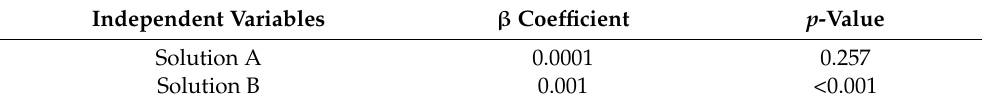
Figure 2. ( a ) Effect of TPP concentration on particle size; ( b ) effect of TPP concentration on PDI; ( c ) effect of TPP concentration on zeta potential.